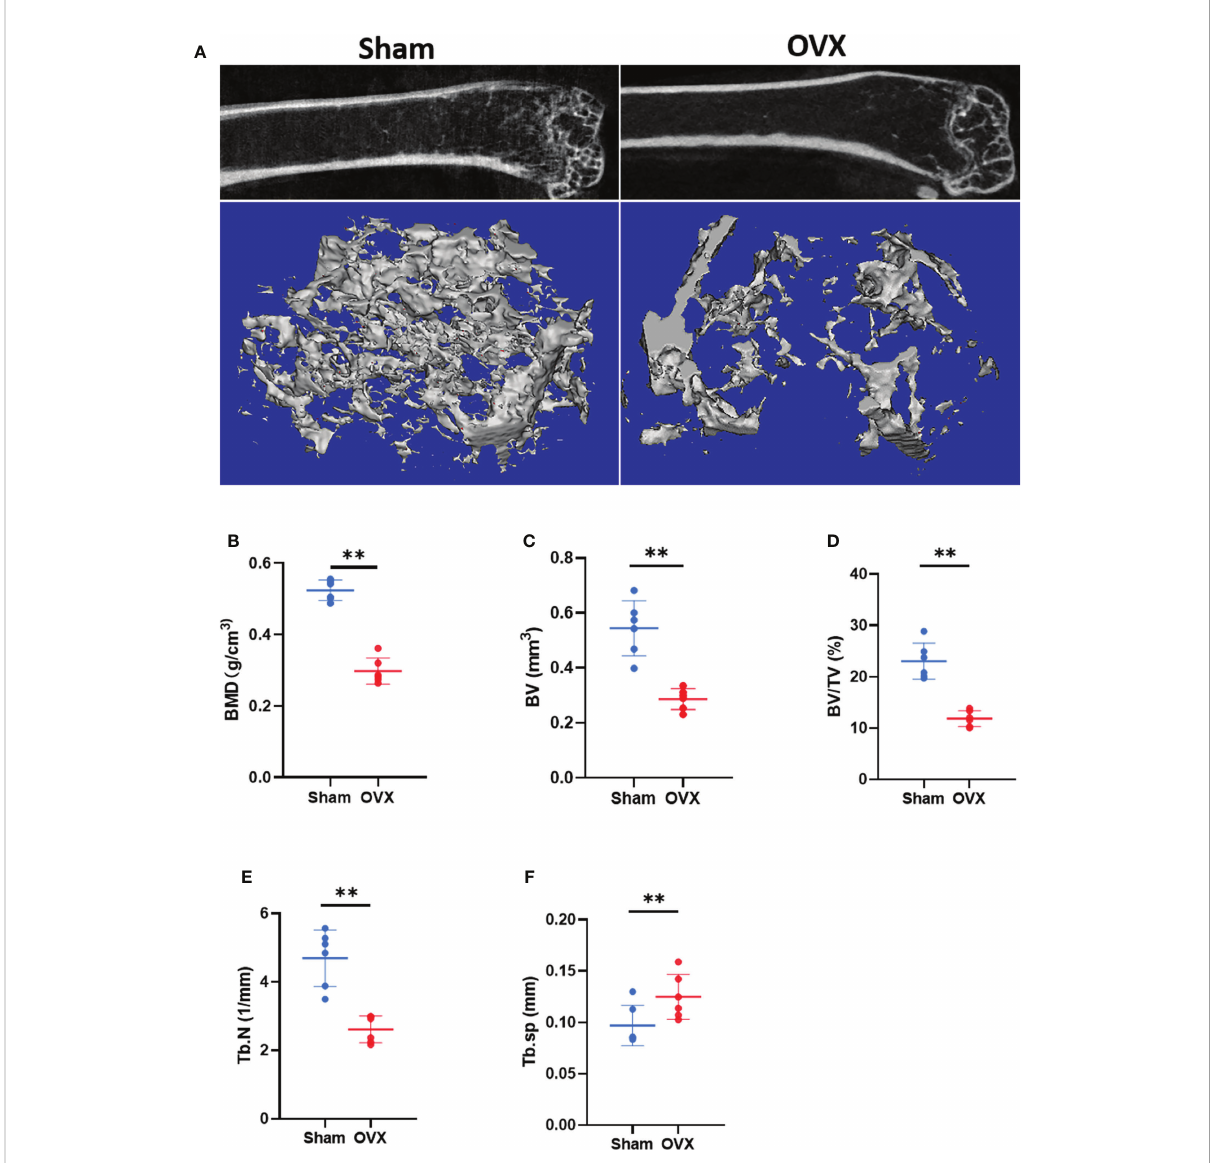
FIGURE 7 Micro CT results and analysis. (A) Representative 3D micro-CT reconstruction images of Sham and OVX group. (B – F) Quantitative analysis of bone parameters. (The data are expressed as the mean ± sd **P <